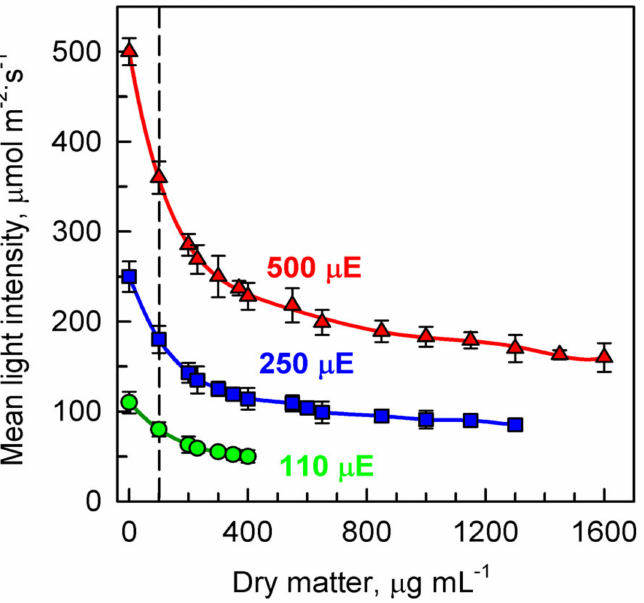
Figure 2. Changes in mean light intensity with increasing dry matter during the cell cycle of synchronous cultures of Parachlorella kessleri grown at different incident light intensities of 500, 250, 110 µ mol photons m − 2 s − 1 ( µ E) at a temperature of 30 ◦ C. Culture growth was started at the same initial dry matter (100 µ g mL − 1 ), indicated by the vertical dashed